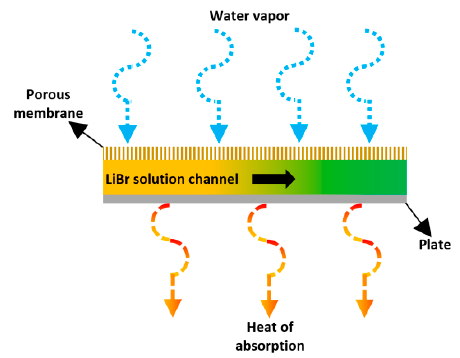
Figure 9. Schematic diagram of the absorber described by Isfahani et al. [52].